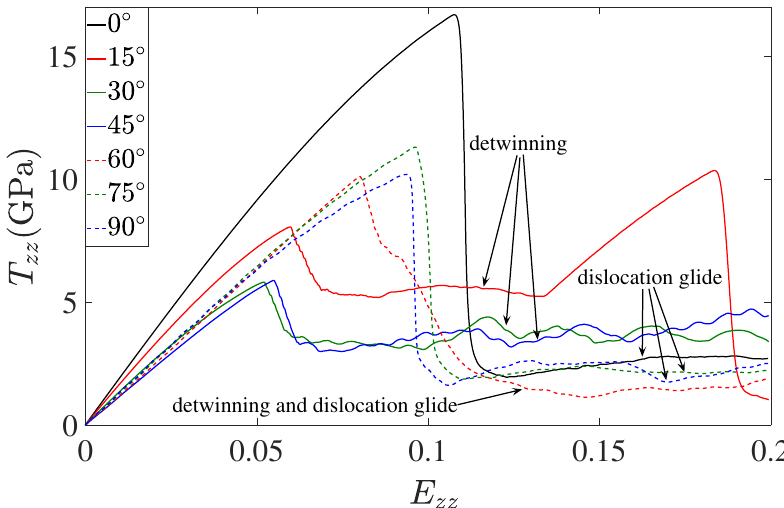
Figure 10. Stress-strain response of the simulation cell in Figure 1 (right) for θ values of 0 ◦ , 15 ◦ , 30 ◦